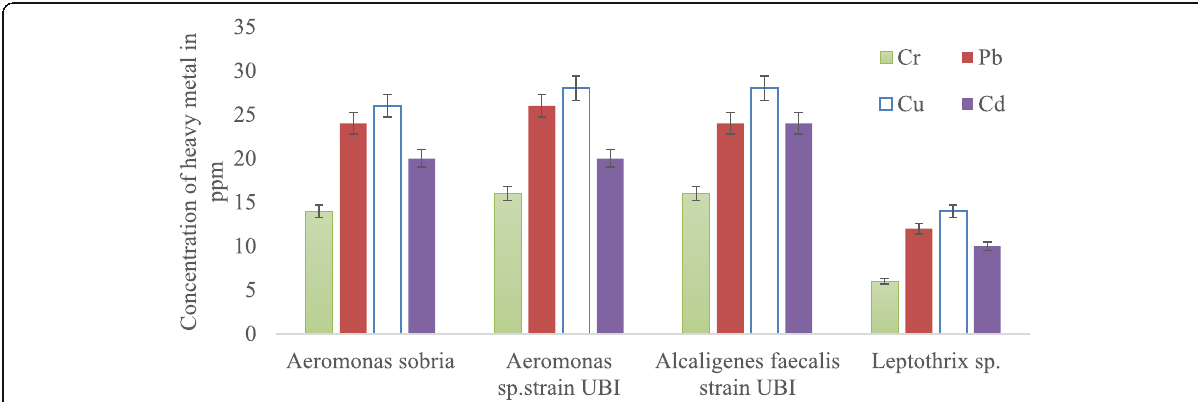
Fig. 7 Agarose gel electrophoresis for PCR product of 16SrDNA showing the four bacterial isolates labelled A ( Alcaligenes faecalis strain UBI), B ( Aeromonas sobria , C ( Aeromonas sp strain UBI), and D ( Leptothrix ginsengisoli